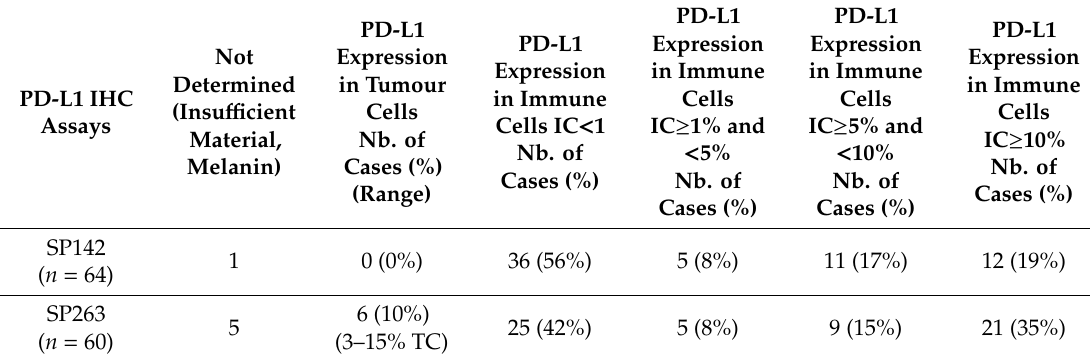
Table 1. PD-L1 TC and IC staining with the 2 PD-L1